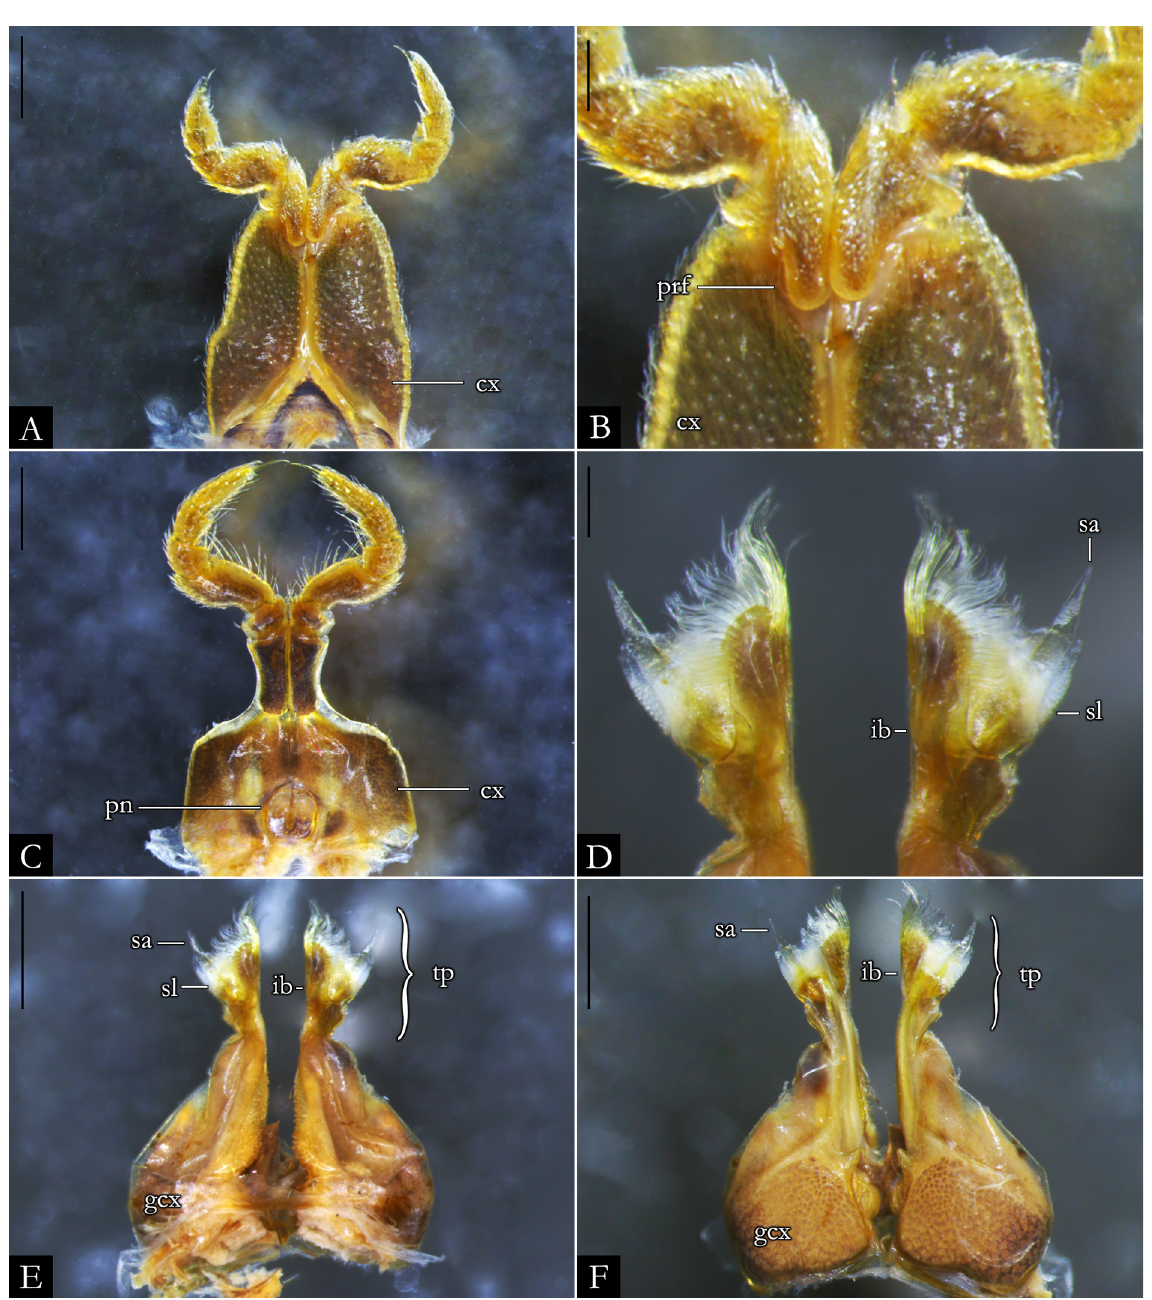
Fig. 99. Pseudonannolene occidentalis Schubart, 1958, ♂ (IBSP 1998). A . First leg-pair. B . Detail of prefemur. C . Second leg-pair. D . Detail of telopodites, in anal view. E . Gonopods, in anal view. F . Gonopods, in oral view. Abbreviations: see Material and methods. Scale bars: A, C, E–F = 0.5 mm; B, D = 0.2